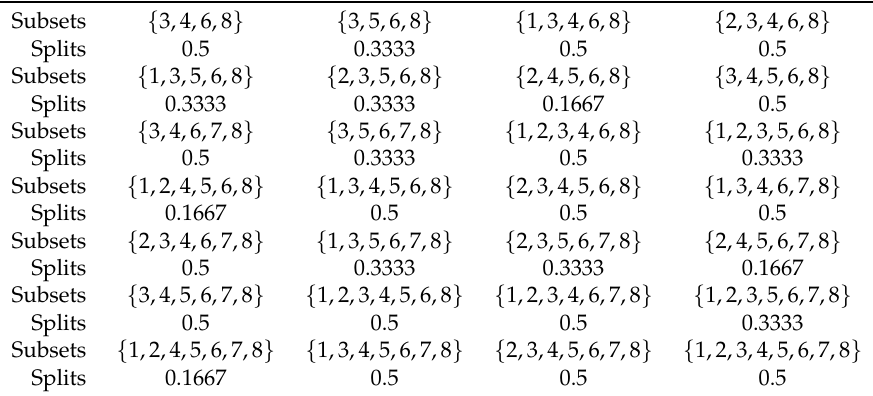
Table 5. The decision subsets with splits larger than zero.